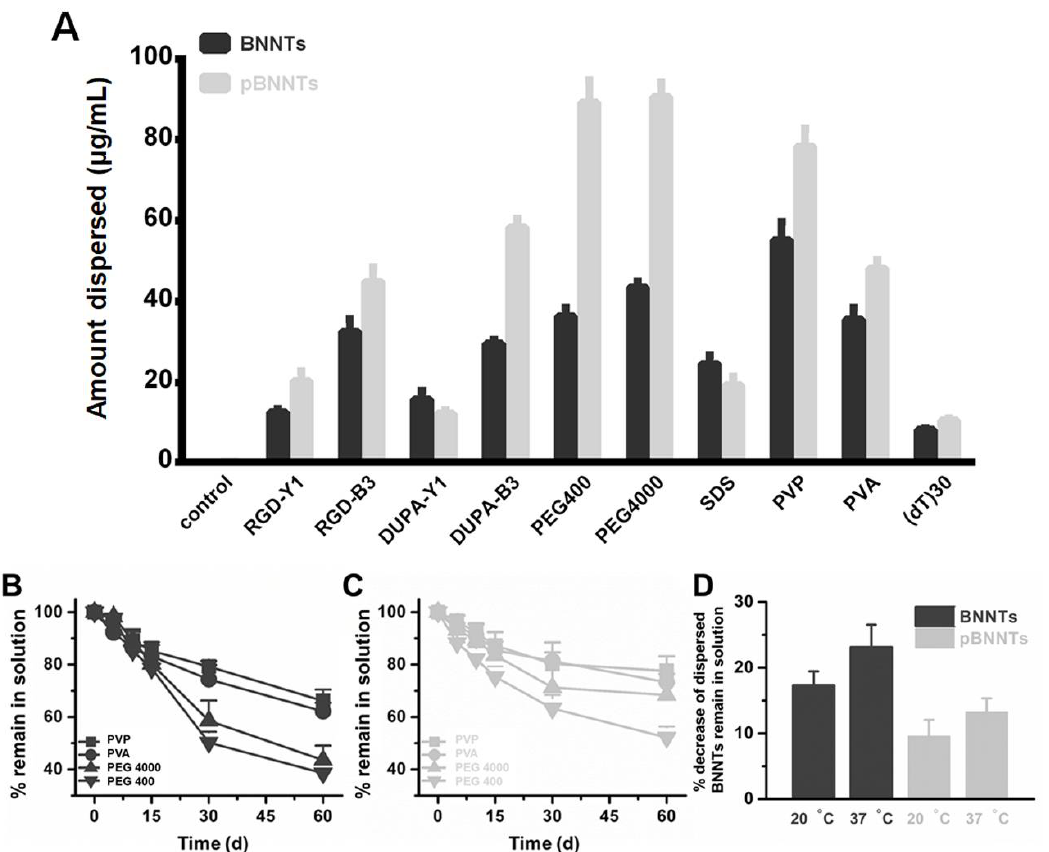
Figure 3. ( A ) The dispersions of BNNTs and their purified form (pBNNTs) in aqueous solution with dispersants. Dispersion stabilities of ( B ) BNNTs and ( C ) pBNNTs with dispersants. ( D ) % decrease of dispersed BNNTs remain in solution at 20 and 37 °C. Error bars represent the standard deviation of three replicates.